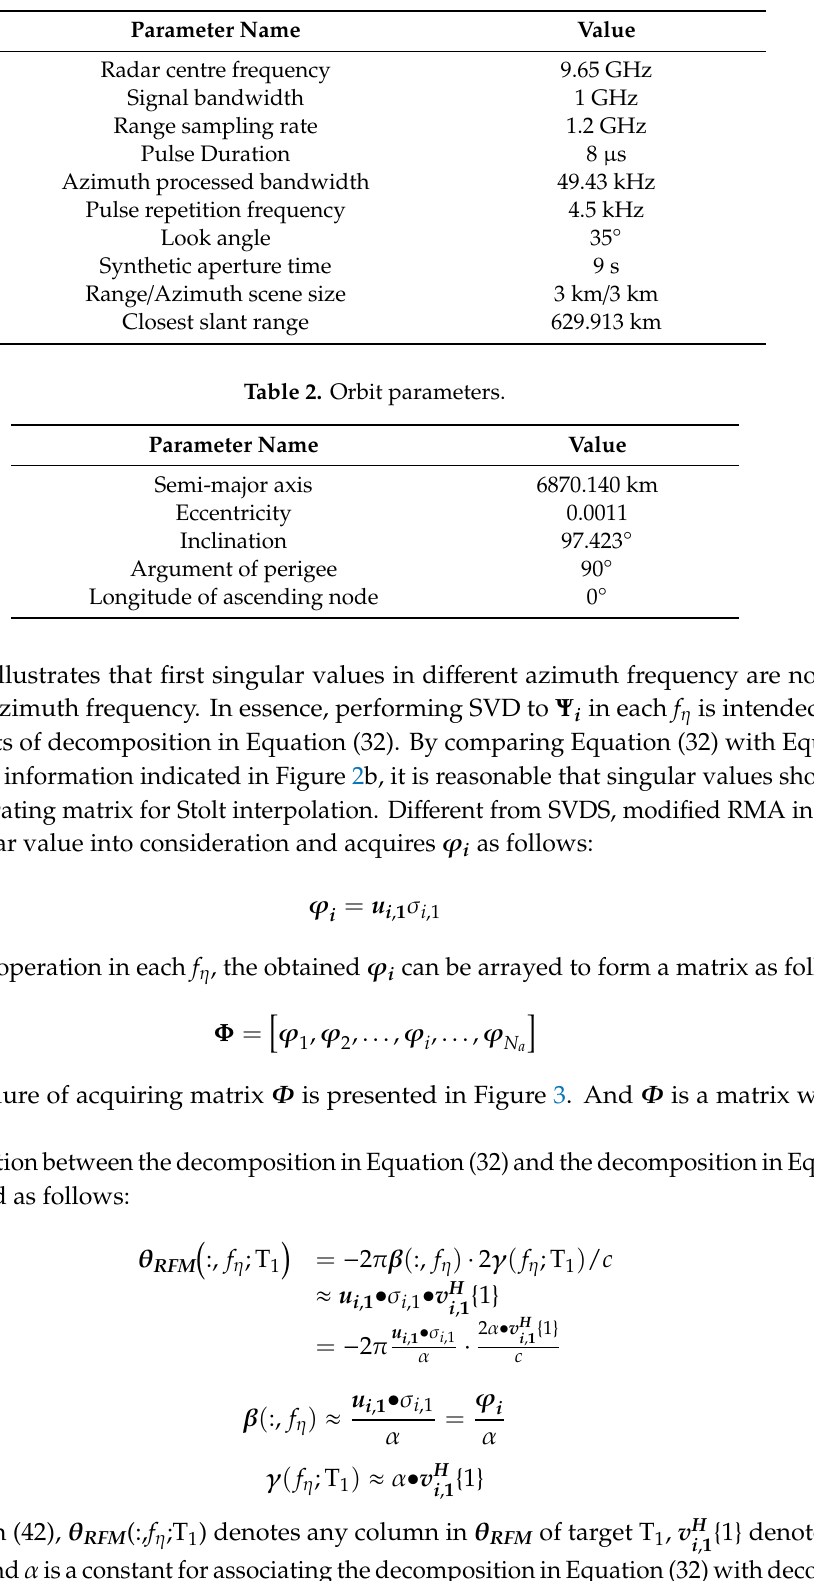
Table 1. SAR system parameters.